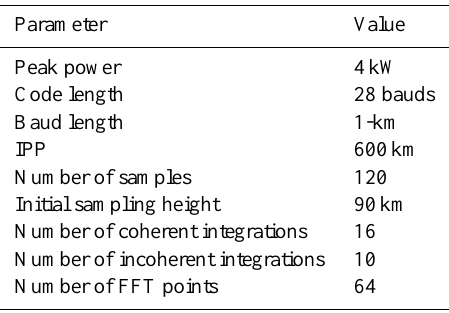
Table 1. Main radar parameters for observations of 150-km